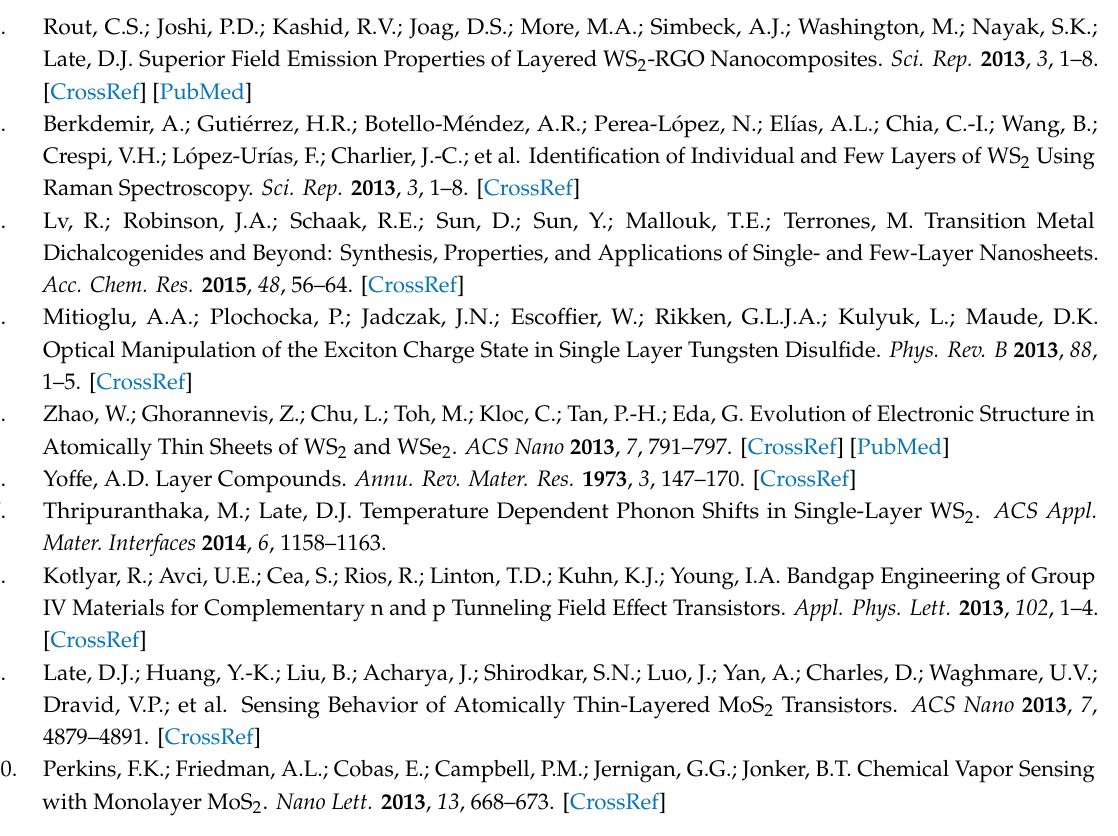
Figure S1: Initial Raman maps and layer count ratio. Figure S2: Initial Raman maps and layer count di ff erence. Figure S3: Simplified schematic depicting WS 2